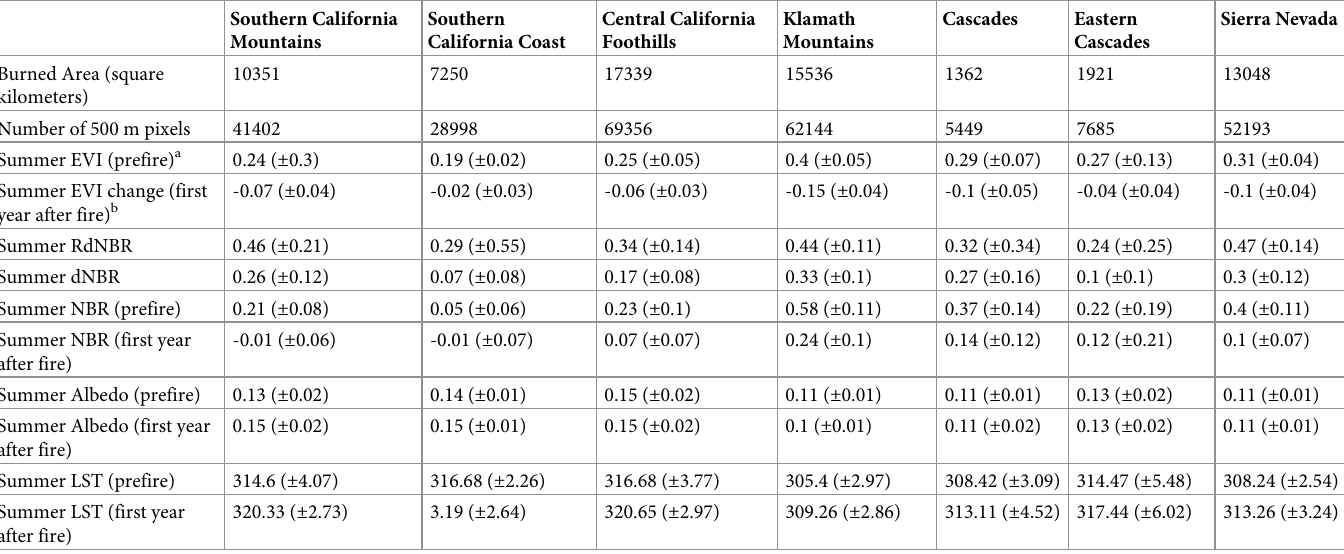
Table 2. Burned area characteristics for each ecoregion averaged for the period